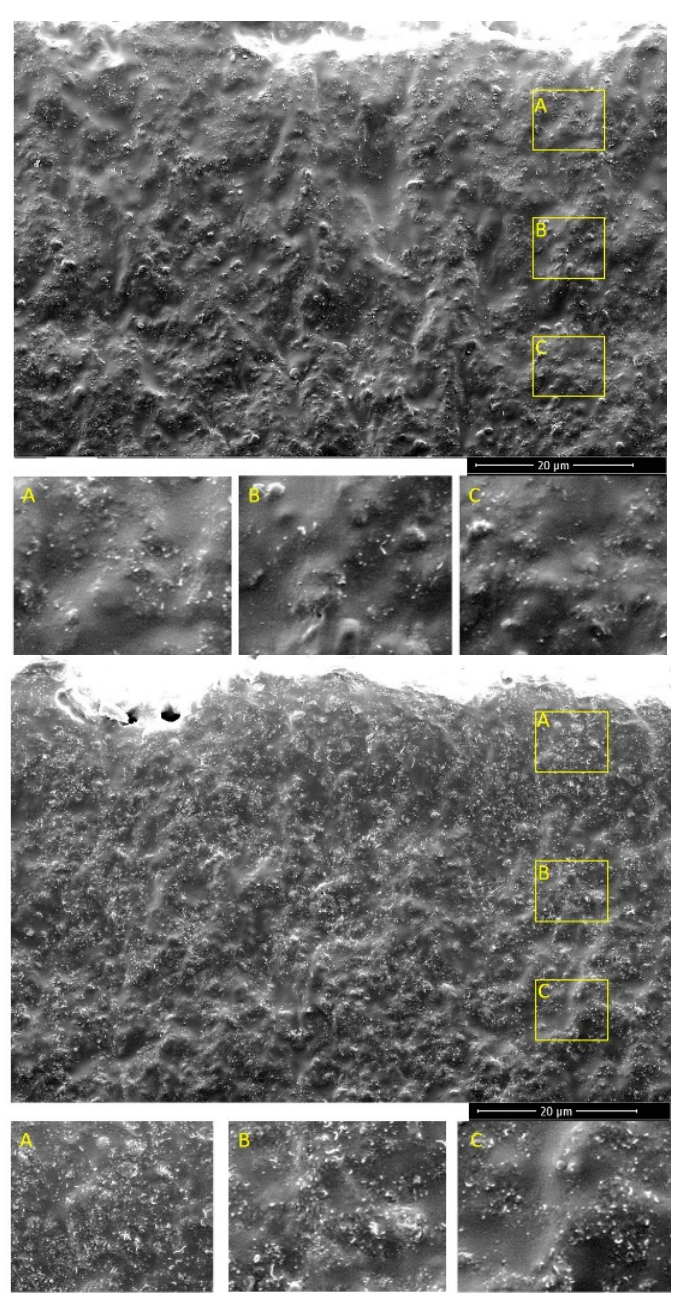
Figure 2. SEM images of silicone composites with 1% CNT (top) and 5% CNT (bottom).